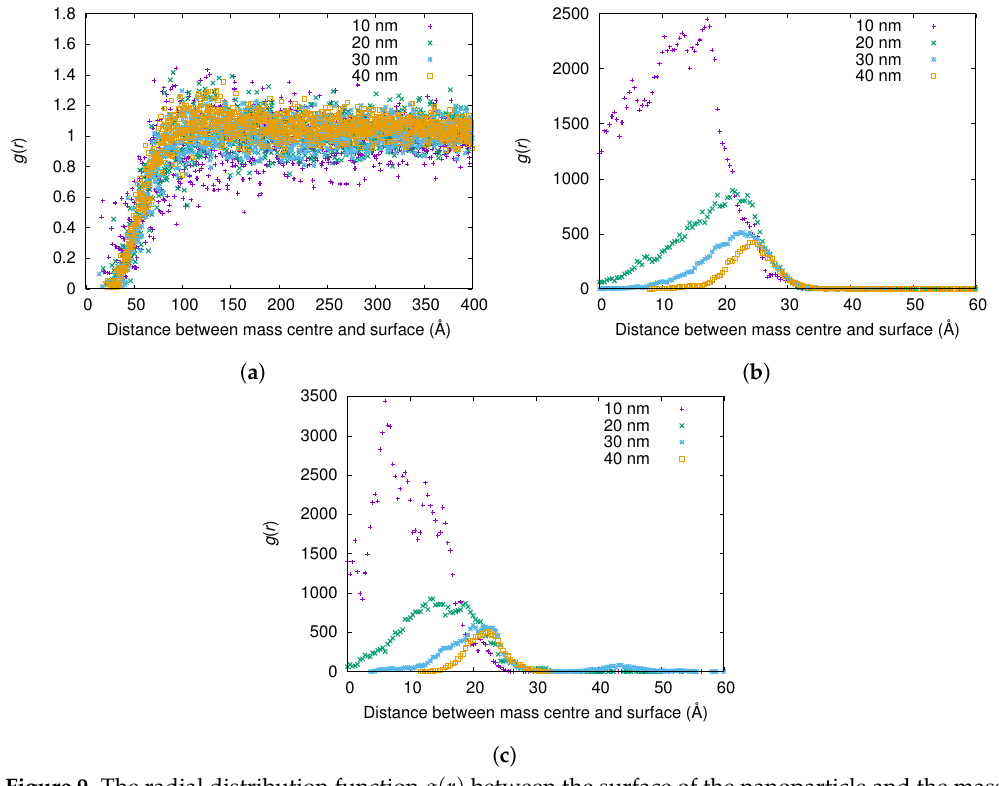
Figure 9. The radial distribution function g ( r ) between the surface of the nanoparticle and the mass center of the α C-chain for different nanoparticle radii and surface charge densities: ( a ) − 0.001 e /Å 2 ; ( b ) − 0.005 e /Å 2 ; and ( c ) − 0.01 e /Å 2 . The g ( r ) are normalized using the (constant) concentration of the α C-chain in the simulation box instead of a bulk concentration for each simulation, since reliable bulk concentrations could not be determined from the simulations with highest attraction to the surface.